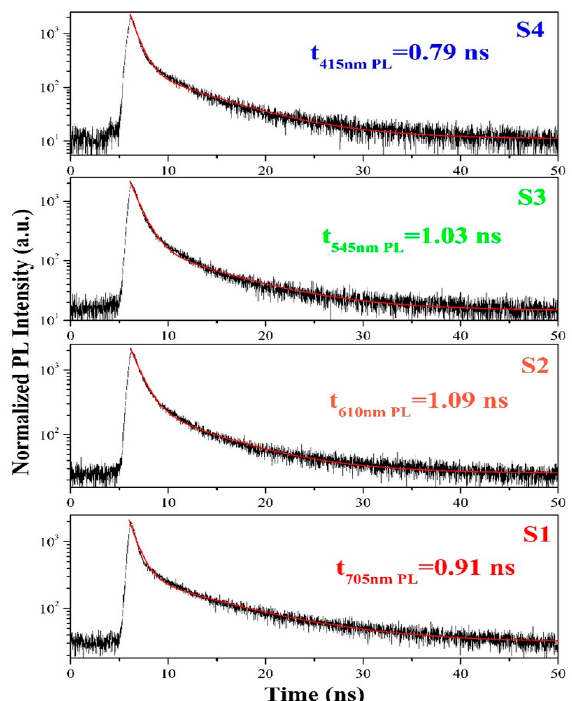
Figure 3. Room temperature time resolved photoluminescence for the SiCO:N films with various NH 3 flow rates.